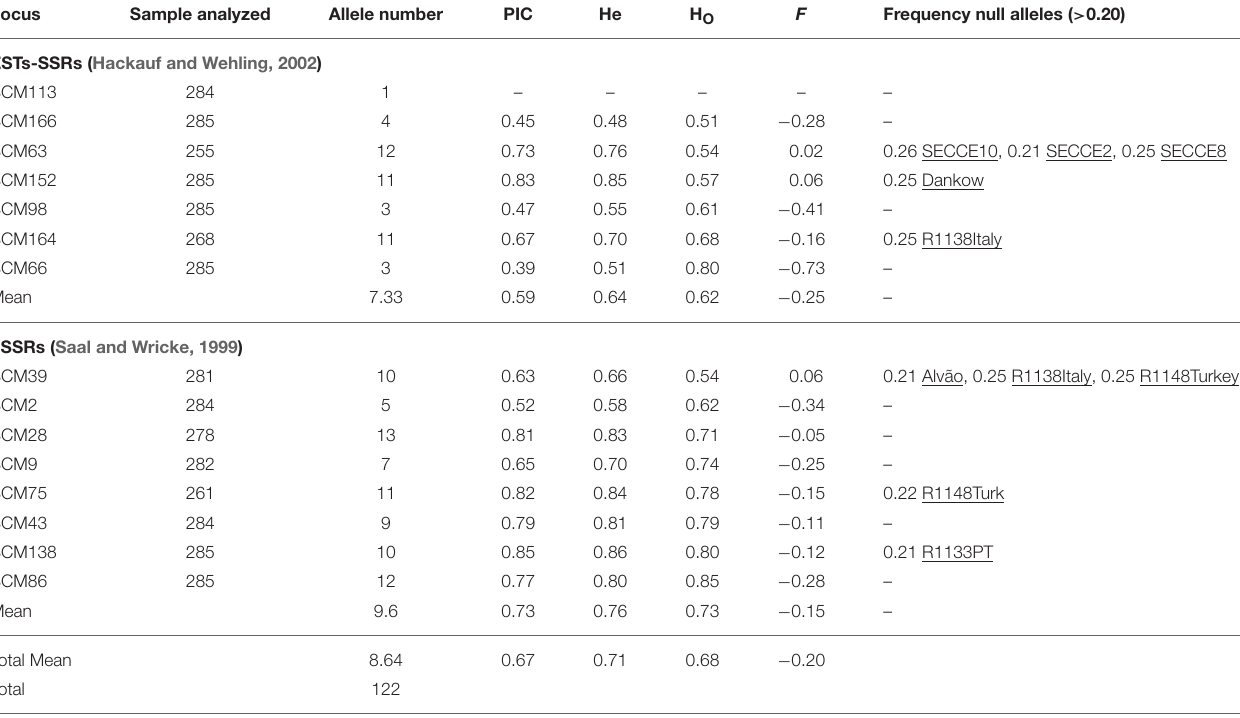
TABLE 2 | Markers diversity measurements. Locus Sample analyzed Allele number PIC He H